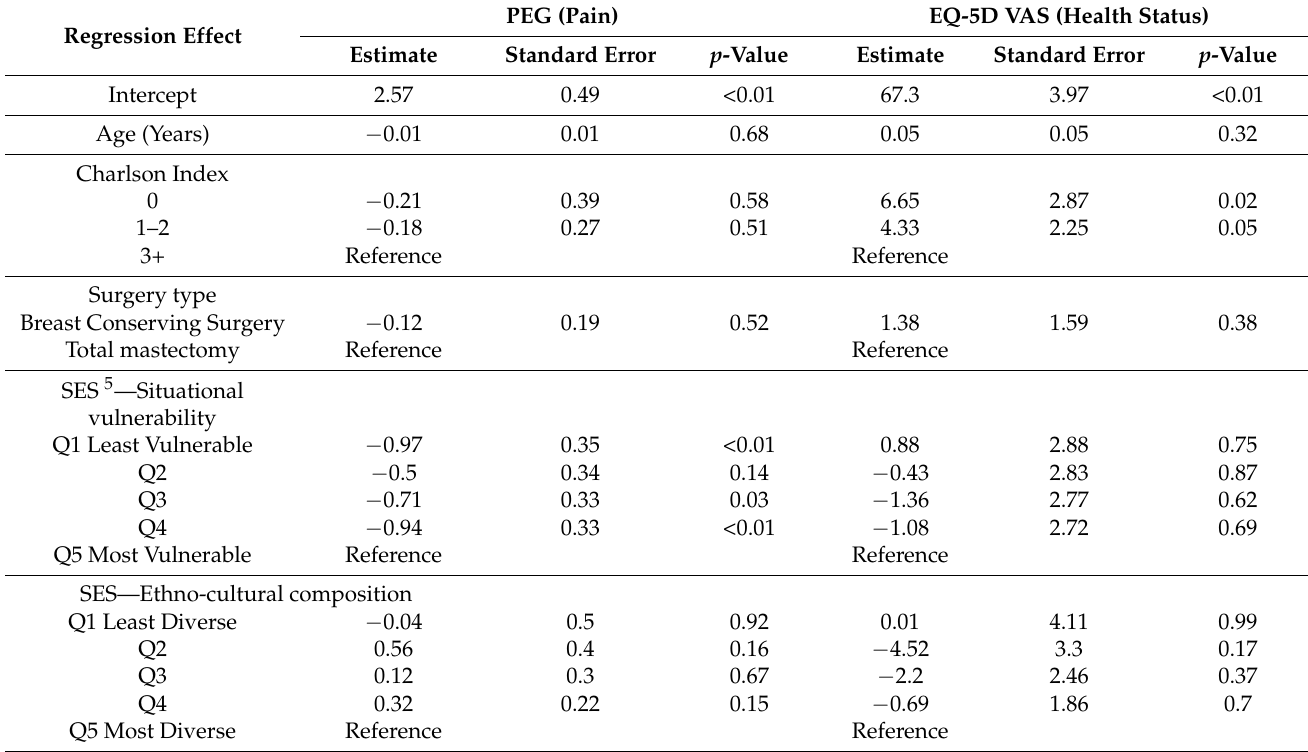
Table A1. Results of regression analyses of PEG pain values and EQ-5D VAS health status values, adjusting for participant’s age, comorbidities, procedure and